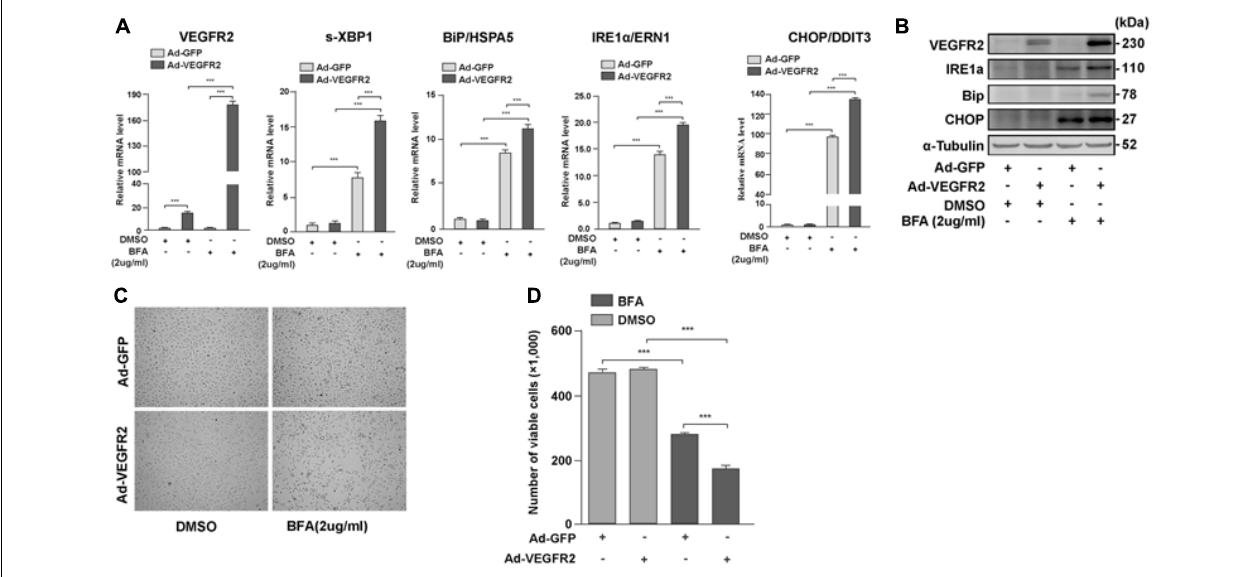
FIGURE 4 | VEGFR2 mediated ER stress is not only limited to glucose deprivation. Overexpression of VEGFR2 further enhanced elevation of ER stress markers at the levels of RNA (A) and protein (B) , and increased cell death (C) . (D) Quantification of (C) . Data in (D) are the means of three independent experiments ( n = 3). All error bars indicate S.D. **** P <